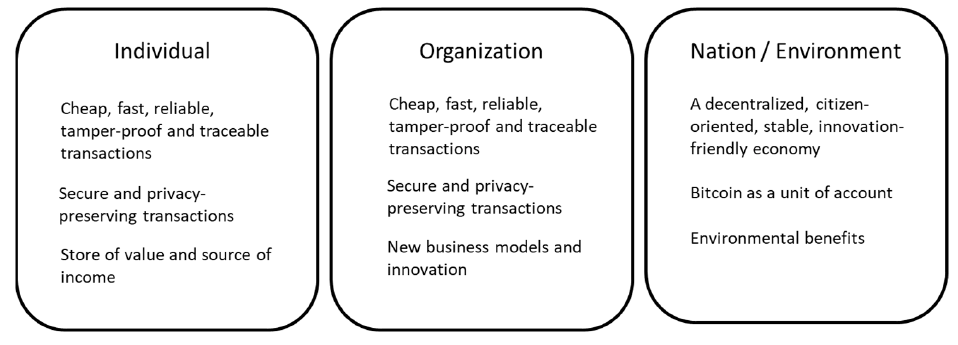
Figure 3. The “best-case scenario” for Bitcoin.